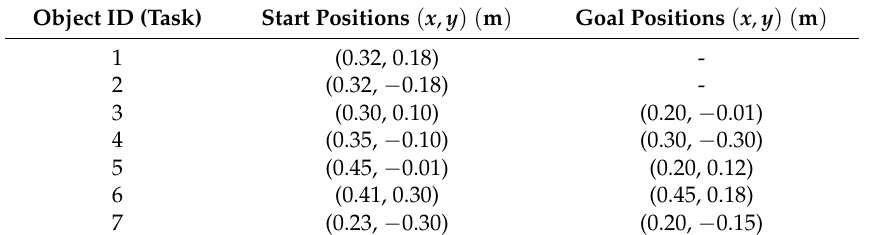
Table 1. Simulation conditions.